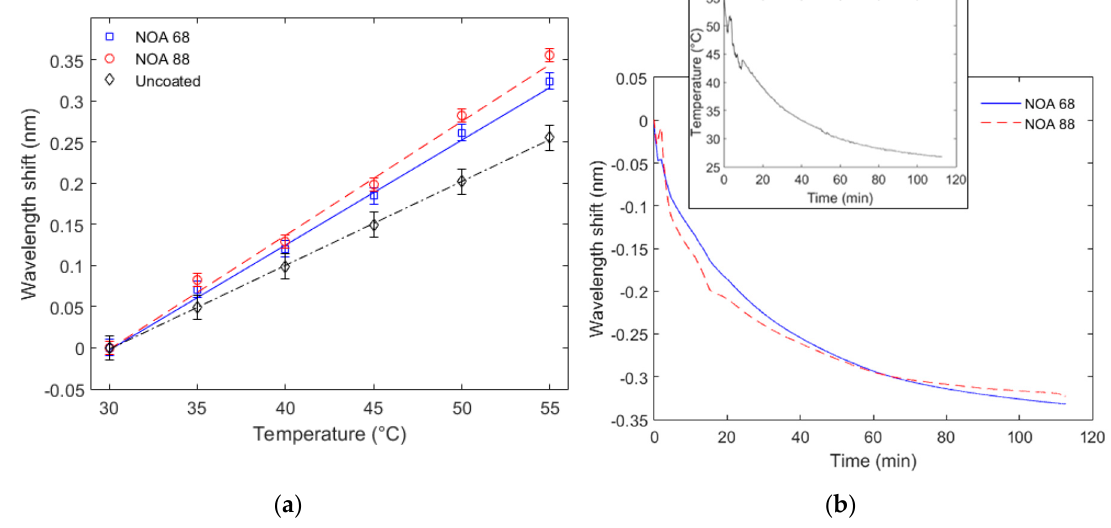
Figure 3. Temperature responses of each coated and uncoated sample. ( a ) Linear regression of wavelength shifts as a function of the temperature. ( b ) Wavelength shift as a function of time for the temperature decrease in both samples. Figure inset shows the temperature variation as a function of the time.